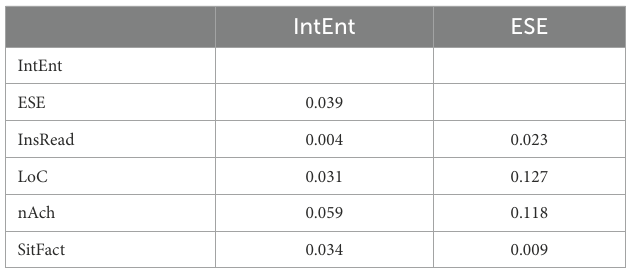
TABLE 8 F 2 predict test.